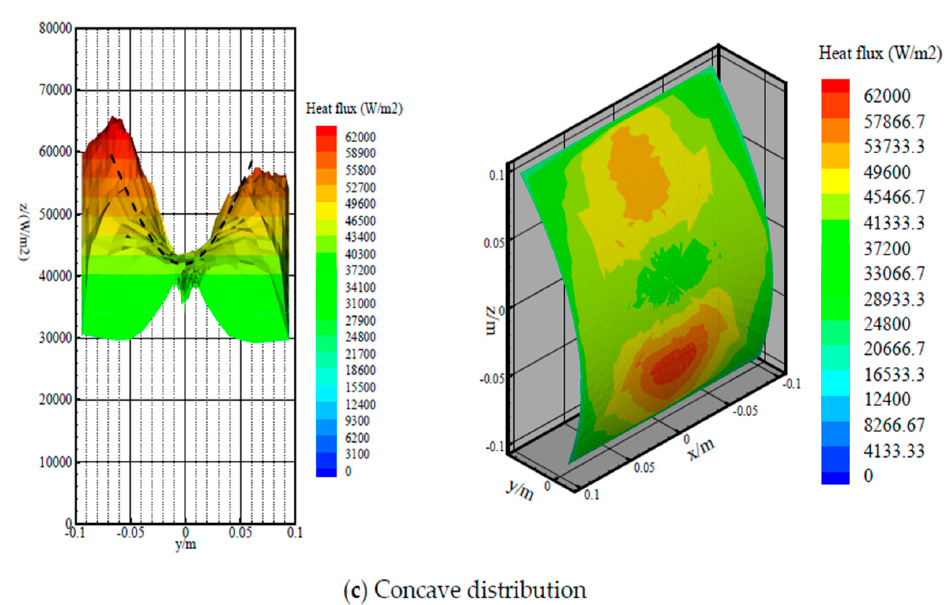
Figure 13. Heat flux distributions after optimization corresponding with different target distributions.